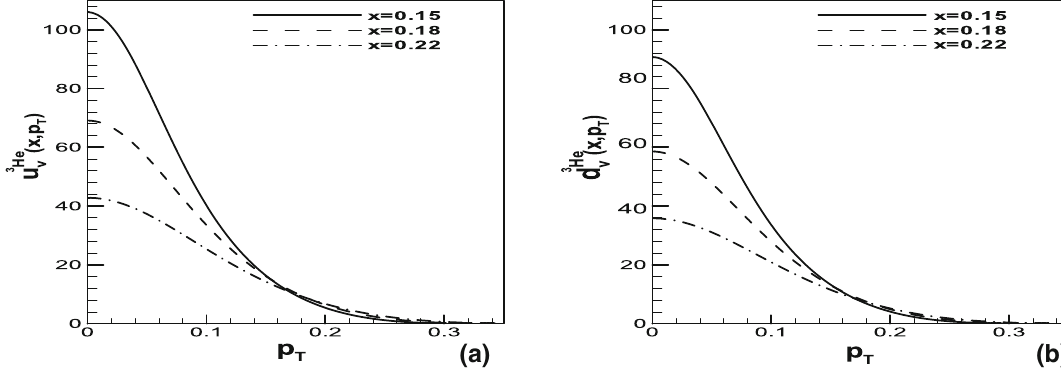
Fig. 5 The TMD valence a u and b d quark distributions of 3 He with respect to p T at x = 0 . 15 , 0 . 18 and 0 . 22